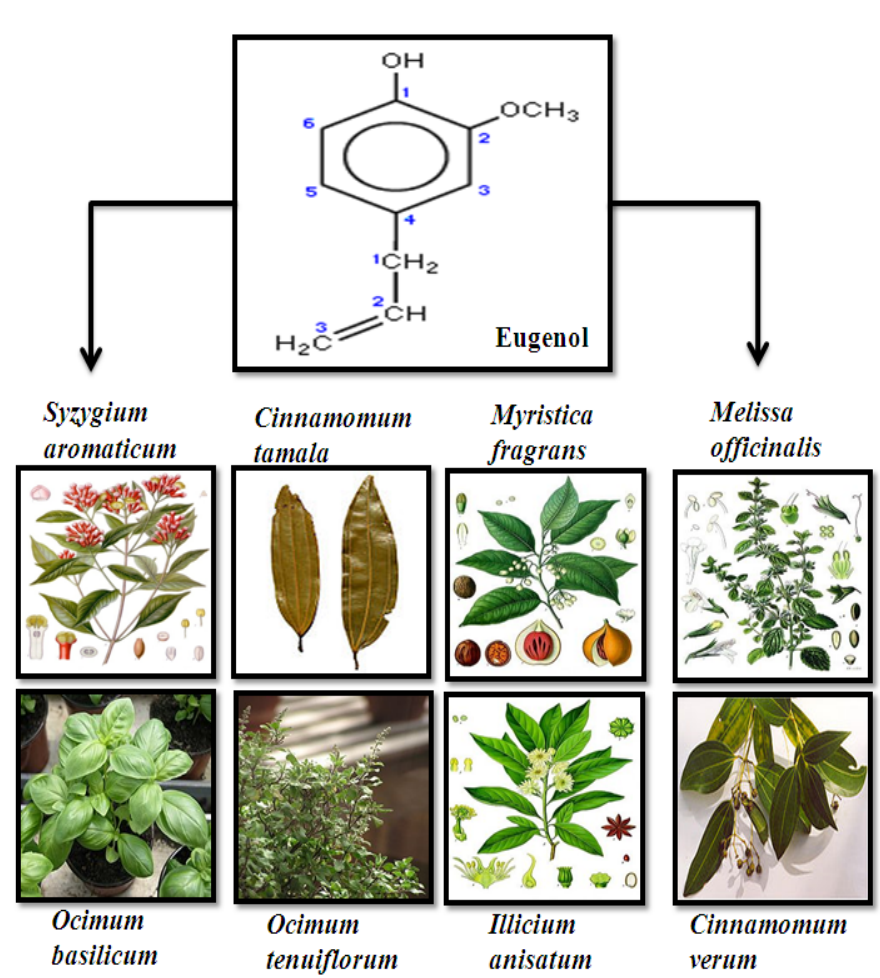
Figure 1. Structure and sources of